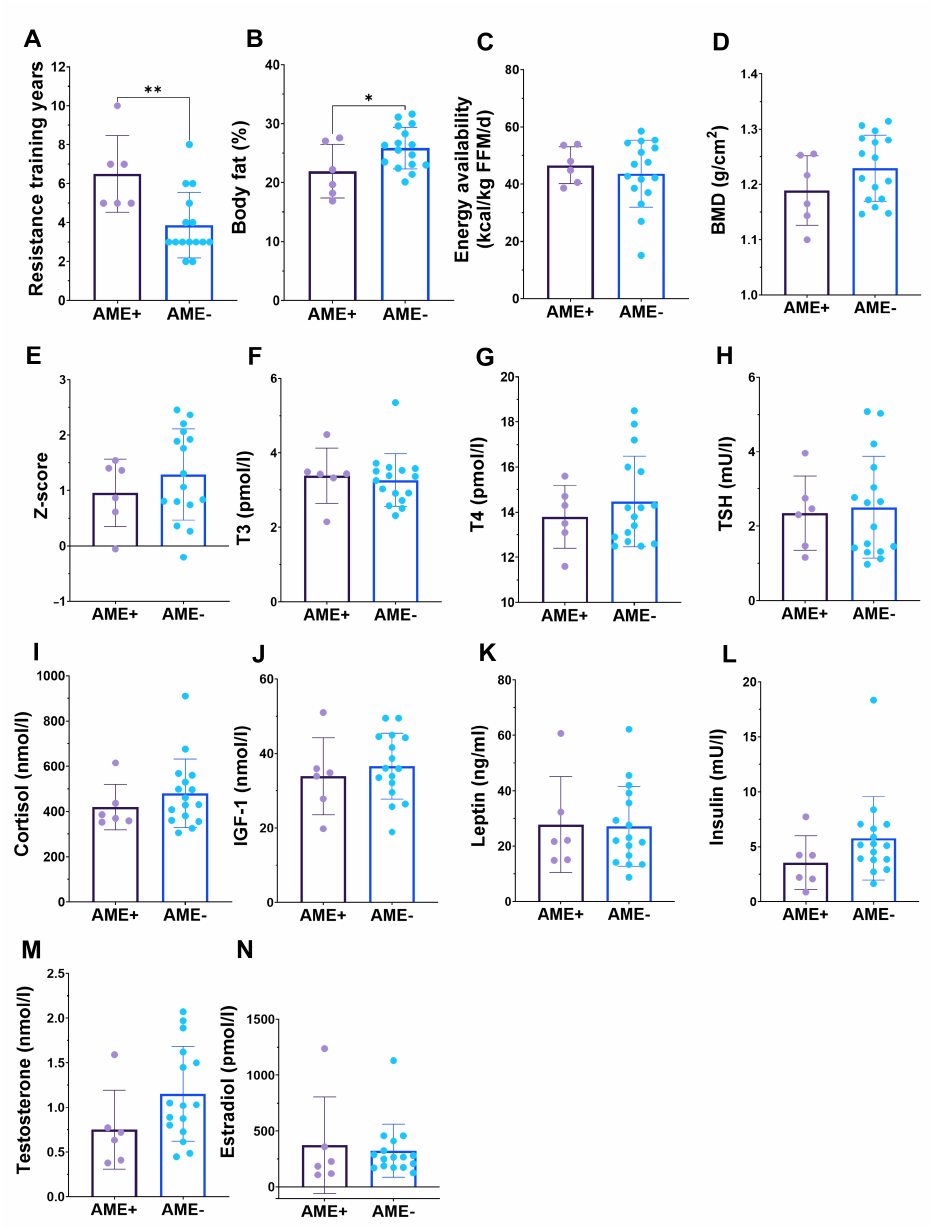
Figure 4. In those athletes who did not use hormonal contraceptives, amenorrheic females (AME+) have similar more resistance training experience in years ( A ) and lower body fat percentage ( B ), but similar energy availability ( C ) bone “health” ( D , E ) and hormonal concentrations ( F – N ) when compared to those who do not have amenorrhea (AME − ). * = p < 0.05 and ** = p <